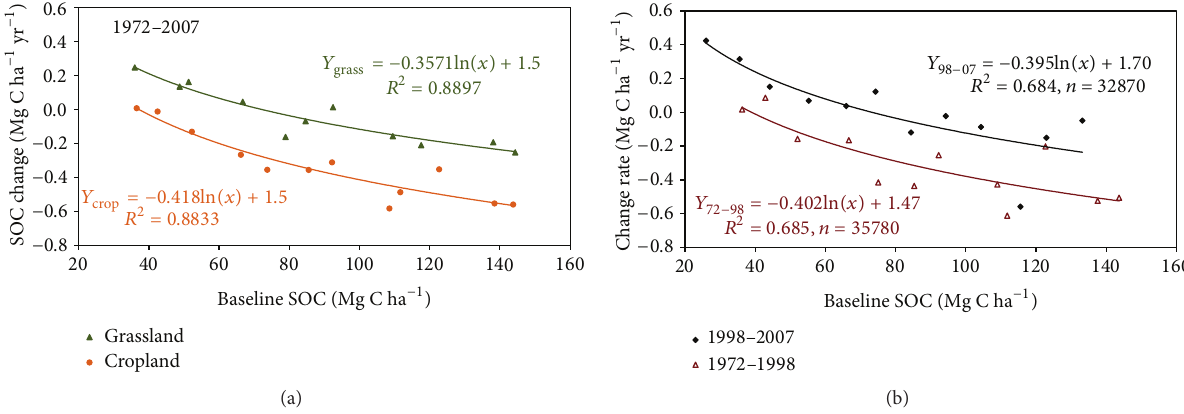
Figure 6: Annual rate of the change in soil organic carbon stock (SOC) in the top 20cm depth of soil as related to the baseline SOC levels across the study area. (a) Annual rate of SOC change from 1972 to 2007 for cropland and grassland; (b) annual rate of SOC change averaged for all land use types from 1972 to 1998 and 1998 to 2007.